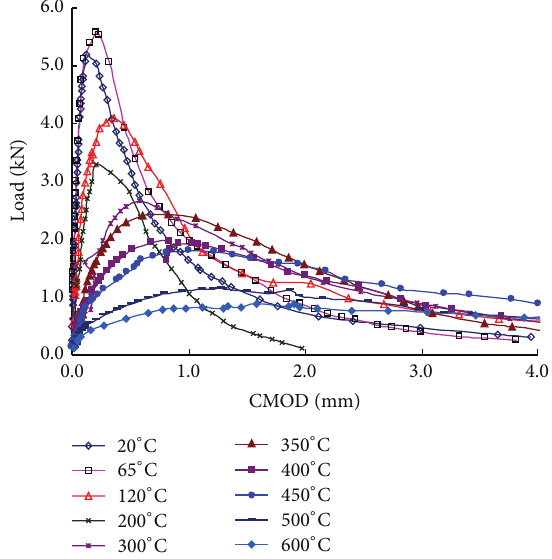
Figure 8: Load versus CMOD curves of specimens with tempera-